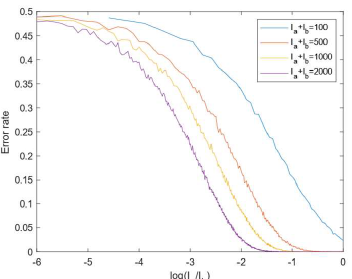
Figure 2. Gray code segmentation error rate for different signal levels (measured in